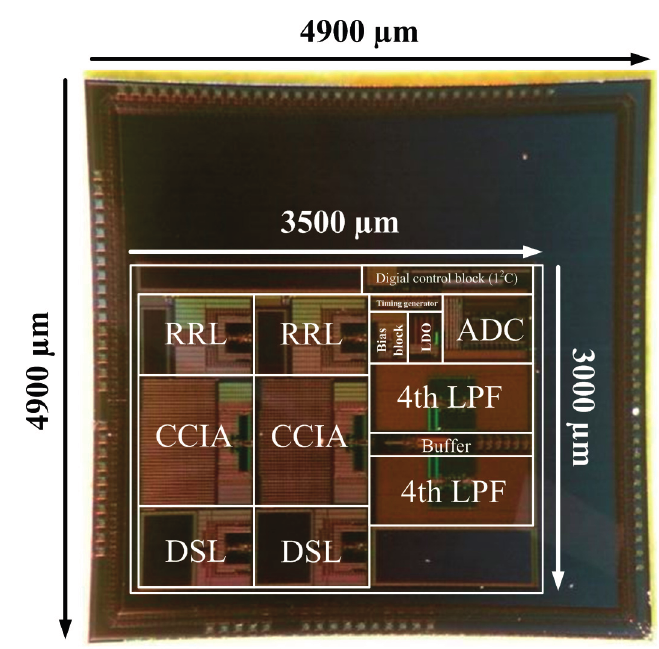
Figure 12. Microphotograph of the biopotential AFE IC.